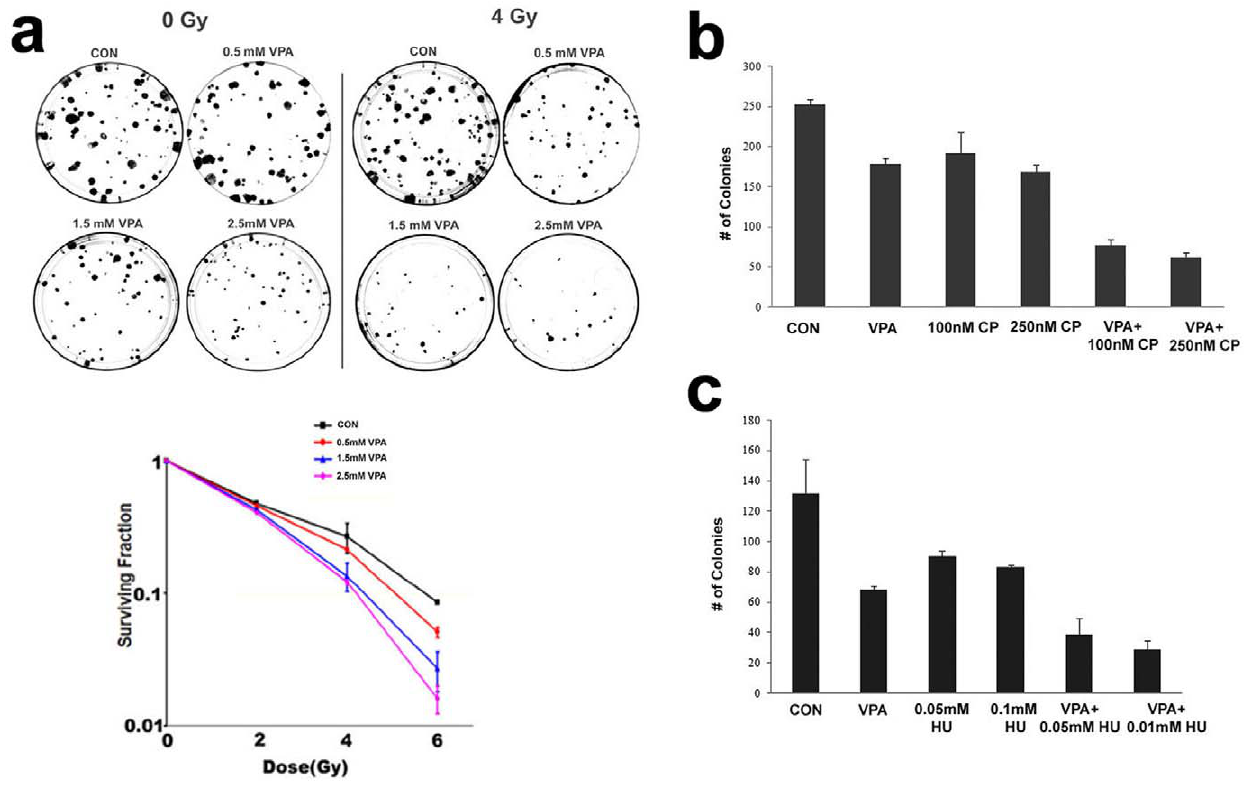
Figure 2. Sensitivity of DU-145 cells to DNA damaging agents upon VPA treatment. a) Clonogenic assay performed in DU-145 after treatment with different doses of VPA for 48 h before irradiation with different doses of radiation. Top panel shows representative clonogenic plates with 0Gy and 4 Gy radiation graph below depicts surviving fraction after VPA treatments and irradiation. Error bar represents standard deviation of three independent experiments. b) Clonogenic assay performed on DU-145 cells treated with 1.5 mM VPA and cisplatin (100 nM and 250 nM) for 48 h. Error bar represents standard deviation. c) Clonogenic assay performed on DU-145 cells treated with 1.5 mM VPA and hydroxyurea (0.5 mM and 1 mM) for 48 h. Error bar represents standard